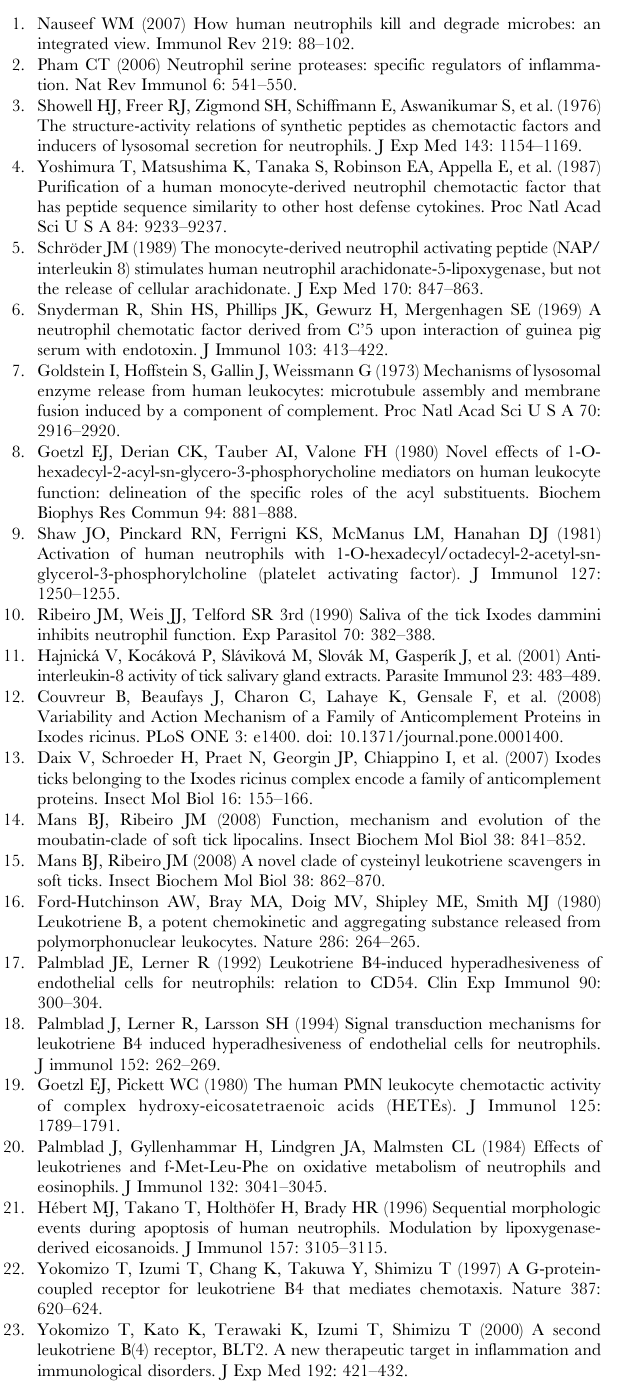
ligand. Proteins are represented by a ribbon, colored by secondary structure succession. Positive and negative residues are in dark blue and red, respectively, hydrophilic and hydrophobic residues are light blue and orange respectively, and Tyr is